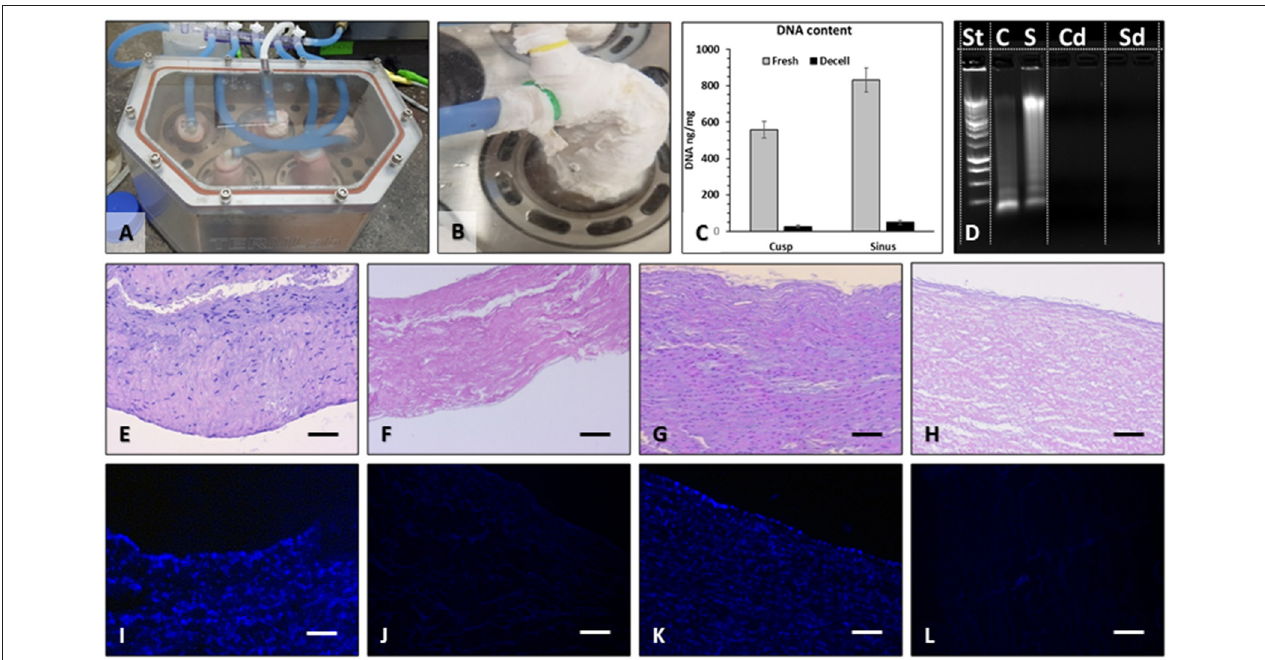
FIGURE 2 | Pulmonary valve decellularization. Valves were mounted onto purpose-designed external supports and inserted into the pressurized system (A) , which perfused each valve individually (B) with detergents and enzymes. For decellularization validation, DNA was extracted from the sinus and cusp tissues and quantified by NanoDrop (C) , using fresh tissues as controls. Extracted DNA was also run on ethidium bromide agarose gels by electrophoresis and imaged in UV light (D) . St, molecular weight DNA standard ladder; C, fresh cusp; S, fresh sinus; Cd, decellularized cusp, two lanes; Sd, decellularized sinus, two lanes. Histology using H&E stain of fresh cusp (E) , decellularized cusp (F) , fresh sinus (G) , and decellularized sinus (H) and using DAPI stain for nuclei (blue) in fresh cusp (I) , decellularized cusp (J) , fresh sinus (K) , and decellularized sinus (L) . Bars in all histology images are 200 µ